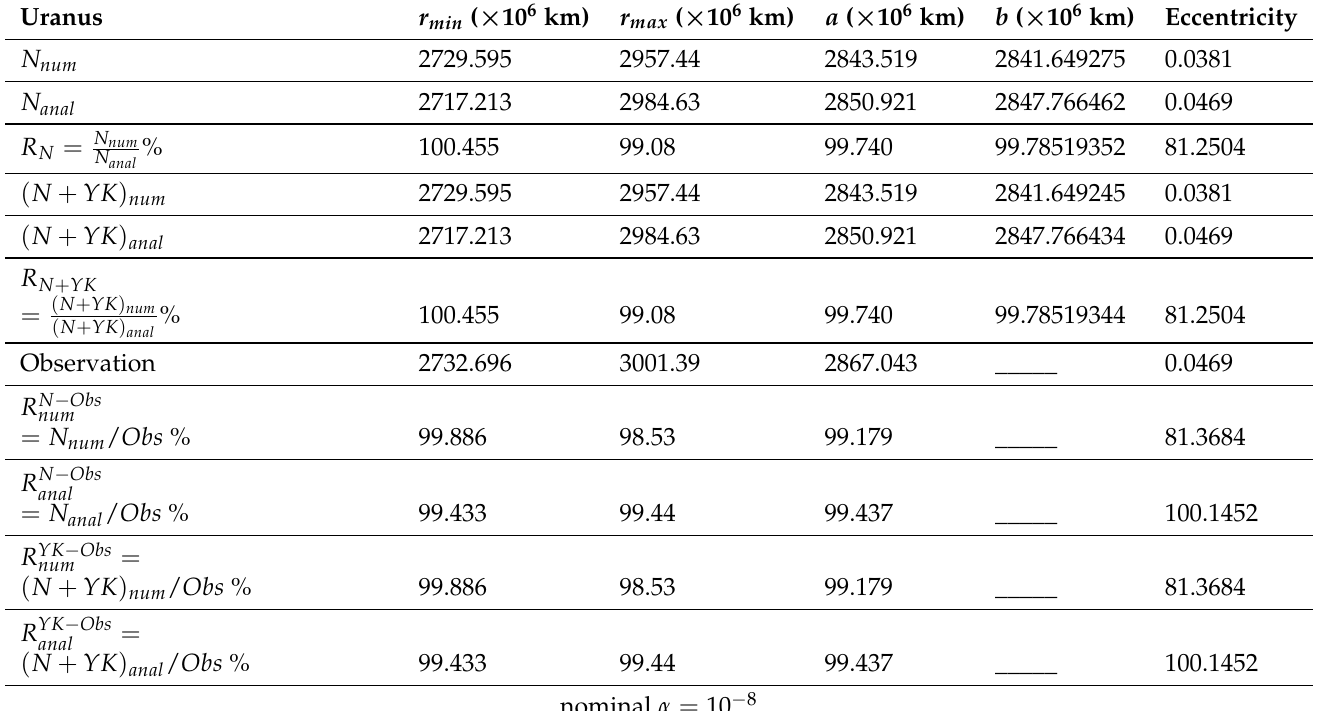
Table A13. The values of the calculated and observational astronomical parameters, for nominal α , of the planet Uranus, whose number of moons is